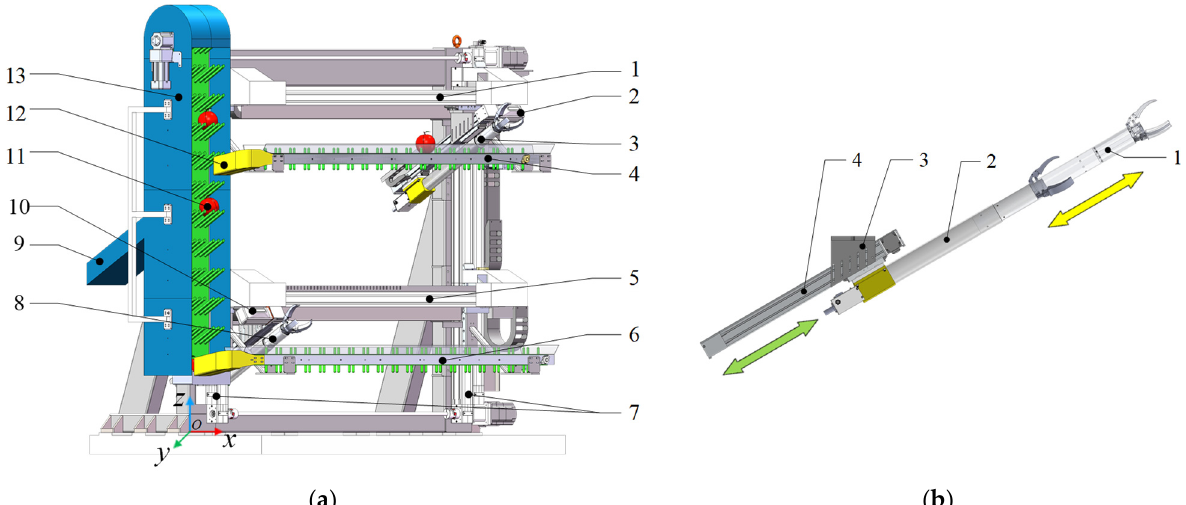
Figure 3. ( a ) Dual-manipulator configuration assembly. (1). Upper horizontal track (2). Vision sensor (upper) (3). Upper picking arm (4). Upper transverse conveying device (5). Lower horizontal track (6). Lower transverse conveying device (7). Vertical tracks (8). Lower picking arm (9). Back outlet of the vertical conveying device (10). Vision sensor (lower) (11). Harvested fruit (12). Transposed elbow (13). Vertical conveying device. ( b ) Two-stage telescopic wireframe diagram of the robotic arm (1). Picking gripper (2). Pneumatic telescopic parts (3). Adjustable angle connecting parts (4). Electric servo telescopic parts.